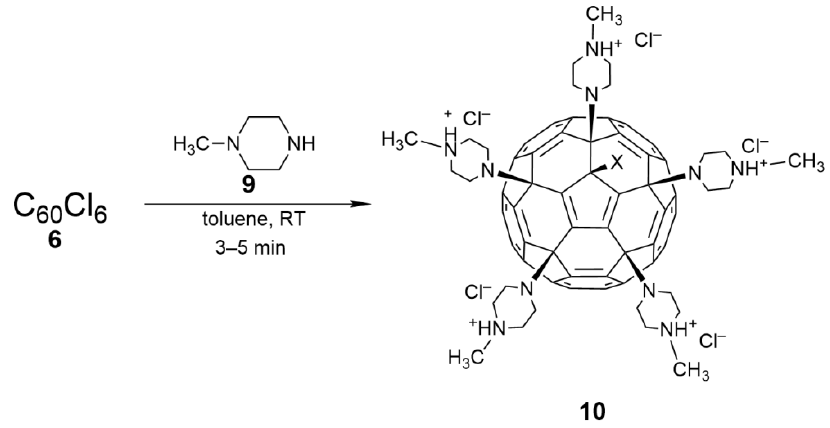
Figure 7. Synthesis route for fullerene penta- N -methyl piperazine salt ( 10 ).